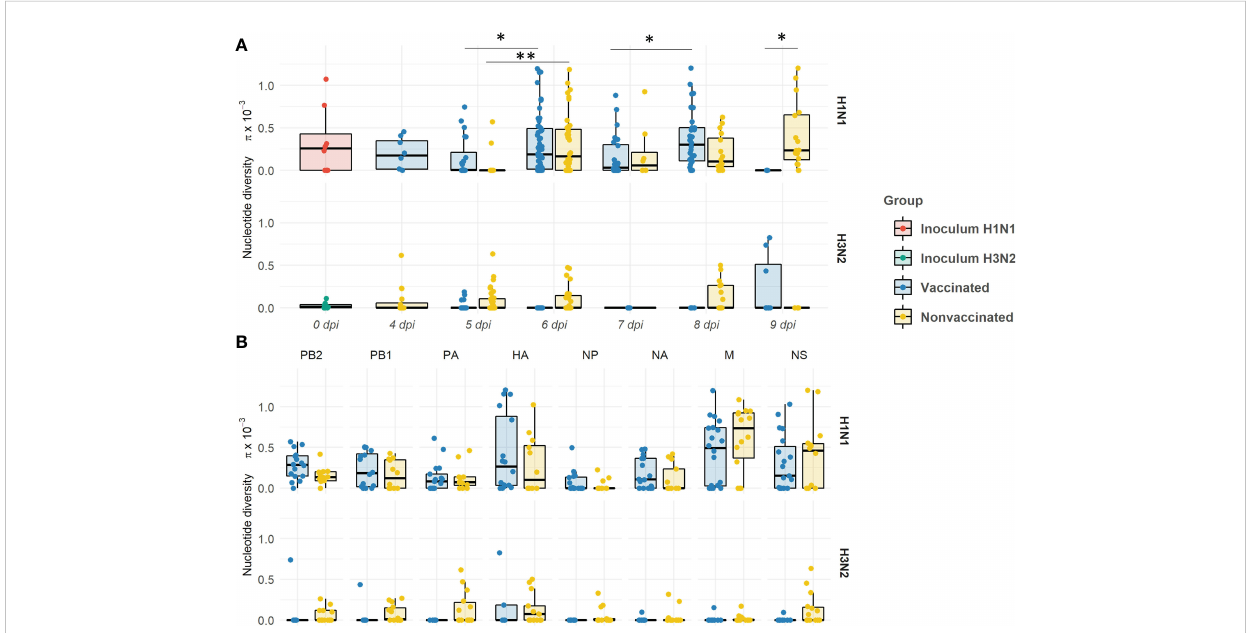
FIGURE 11 Evolution of the nucleotide diversity ( p ) in H1N1 and H3N2 viral quasispecies in vaccinated and nonvaccinated animals over time (A) and per genomic segment (B) . Dots in the boxplot indicates p in each genomic segment. Boxplots indicate means, lower and upper quartile, and standard deviation. The nucleotide diversity of H1N1 and H3N2 inocula, and samples collected from vaccinated and nonvaccinated animals are represented in red, green, blue, and yellow respectively. * P < 0.05 and **P < 0.001.